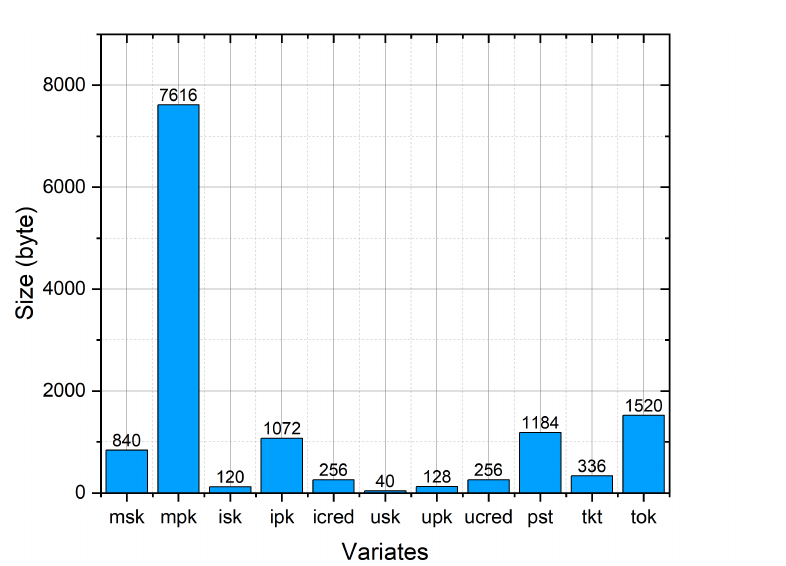
Figure 14. Storage size of